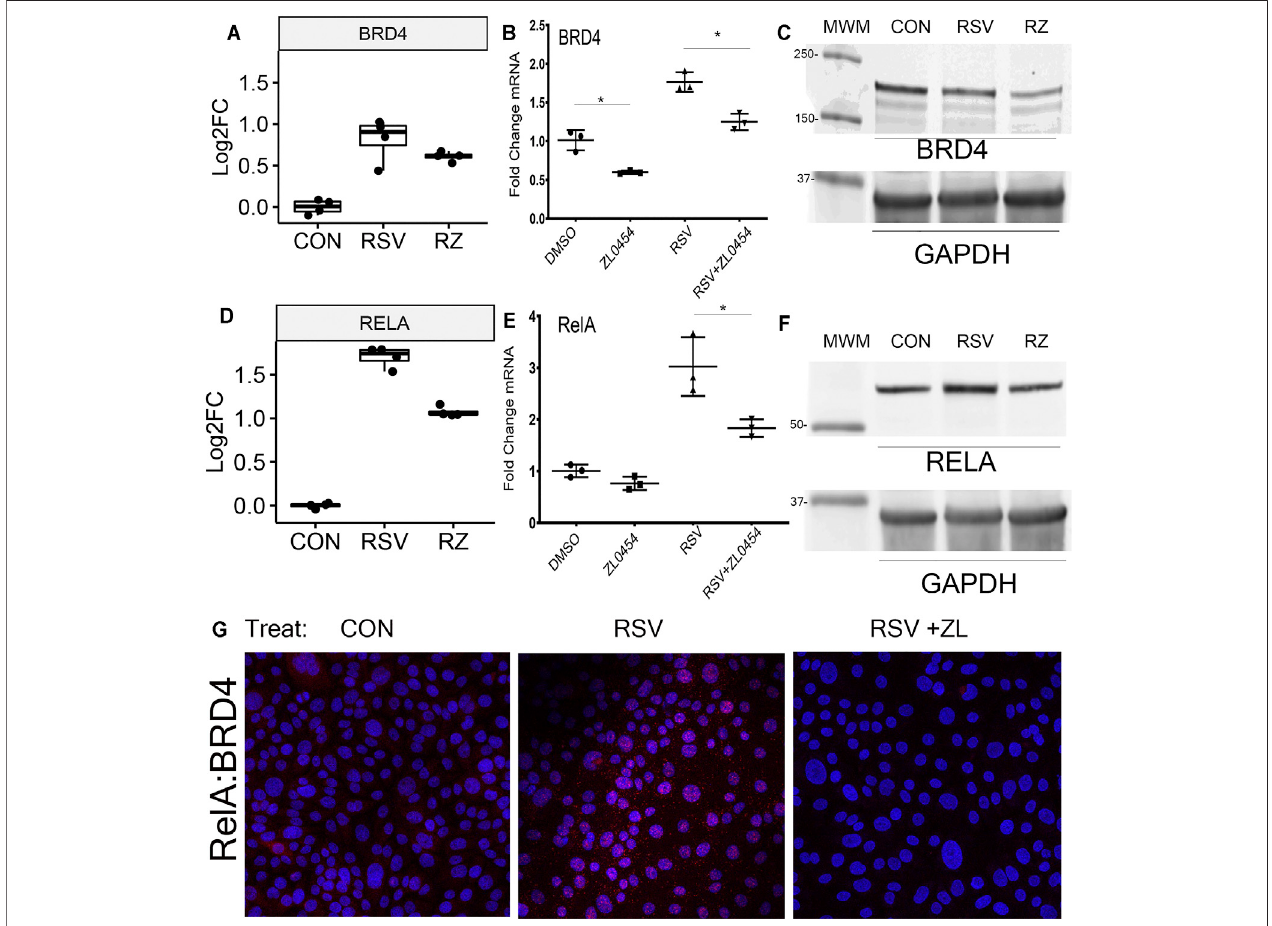
FIGURE6| BRD4autoregulation. (A) BRD4 mRNAexpression. Shownare log2FCcounts fromRNA-Seq plottedas25-7% interquartile ranges. Adjusted p- value for DESeq2 contrast RSV vs RSV + ZL0454 is 0.043. (B) Validation in independent experiments by qRT-PCR. BRD4 mRNA is expressed as fold change over mock- infectedcontrols.NotethebasalandRSV-inducedinductionof BRD4 mRNAisblockedbytheBRD4inhibitor.* p < 0.05posthocTukey ’ scomparisontest. (C) Western immunoblot. Wholecell lysates werefractionatedbySDS-PAGE and blotted forBRD4. GAPDH stainingistheinternal control. MWM, molecular weightmarkers(in kDa). (D) RELA mRNAexpression inlog2FC.Adjusted p- valuesfortheRSV vsRSV +ZL0454contrastis6.07E-23. (E) RELA mRNAexpression byqRT-PCR. * p < 0.05 post hoc Tukey ’ s comparison test. (F) NF κ B/RelA expression. Western blot of whole cell extracts. GAPDH staining is the internal control. (G) Proximity ligation assay. RelA – BRD4 interaction was quanti fi ed using PLA. BRD4 – RelA complexes were quanti fi ed in the control group(Con), RSV-infected, or RSV + ZL – treated HSAECs. Red dotsareBRD4-RelAcomplexesand nucleiarecounterstainedwithDAPI(Blue).NotethatthemarkedinductionofBRD4-RelAcomplexesbyRSVisblocked byZL0454